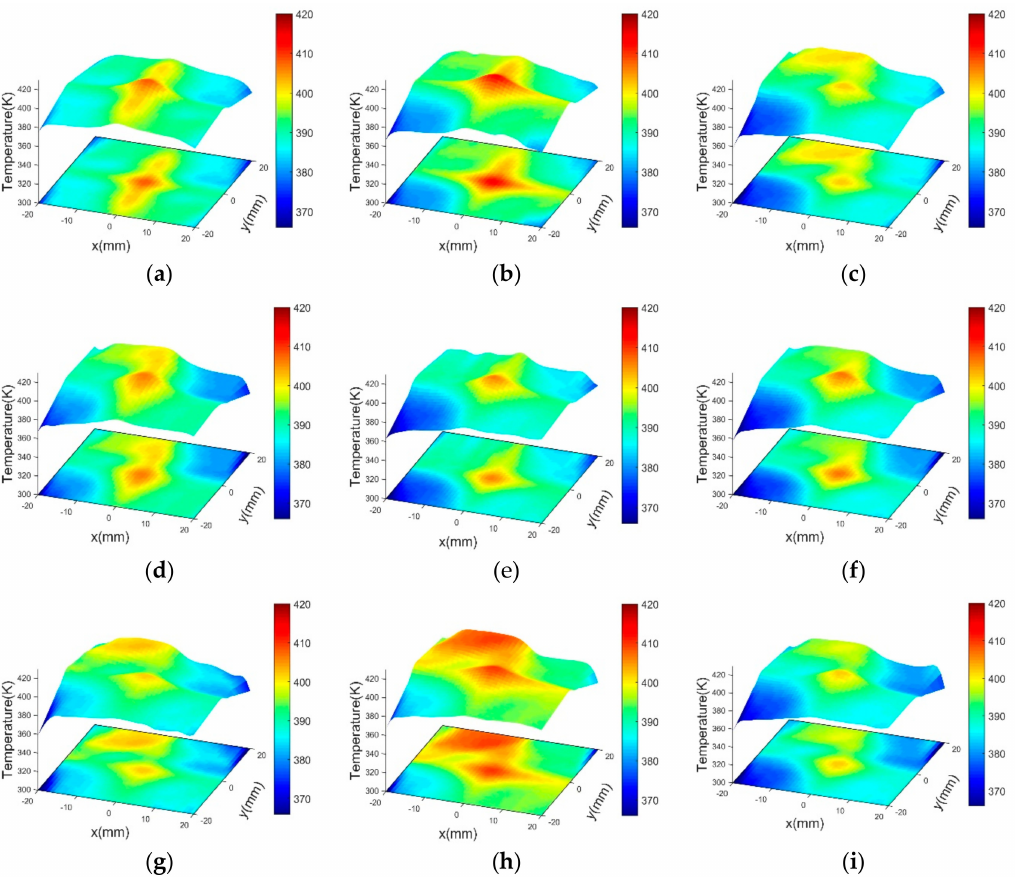
Figure 12. 2D reconstruction temperature distributions at 201 cycles: ( a ) 1.0 s; ( b ) 2.0 s; ( c ) 3.0 s; ( d )